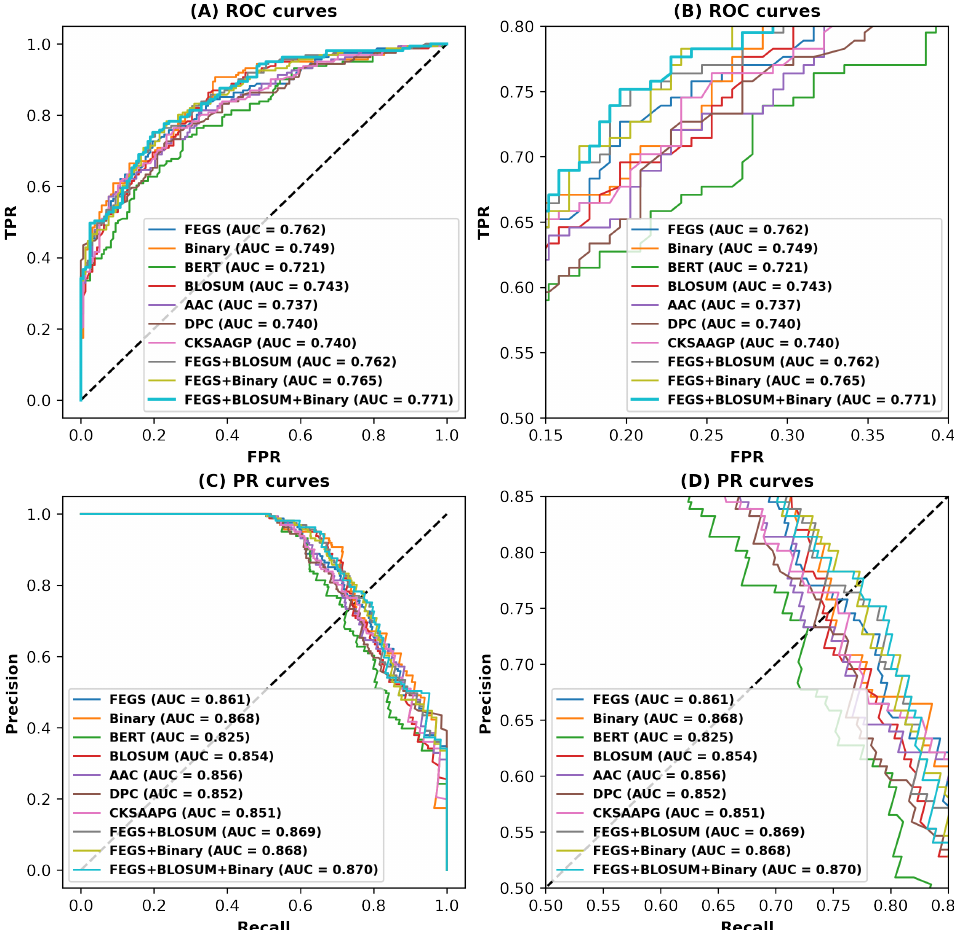
Figure 2. ROC and PR curves for different features or feature combinations on the independent test set of Set 1. ( A ) ROC curves. ( B ) ROC curves for partially enlarged. ( C ) PR curves. ( D ) PR curves for partially